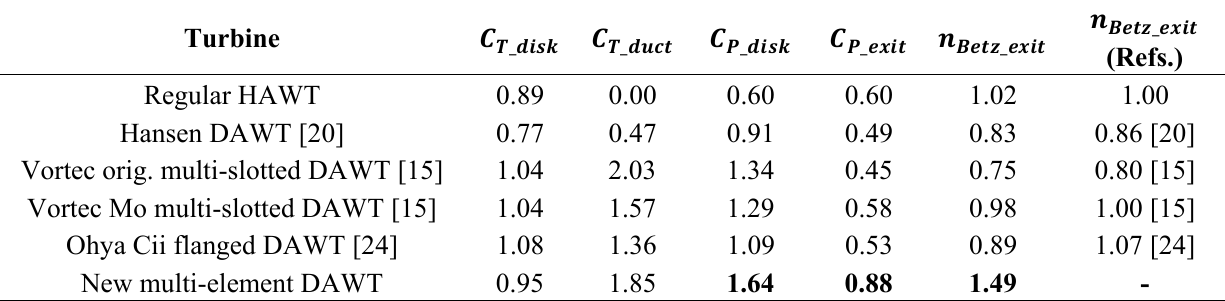
Table 3. Power-optimal RANS-CFD performance result summary.